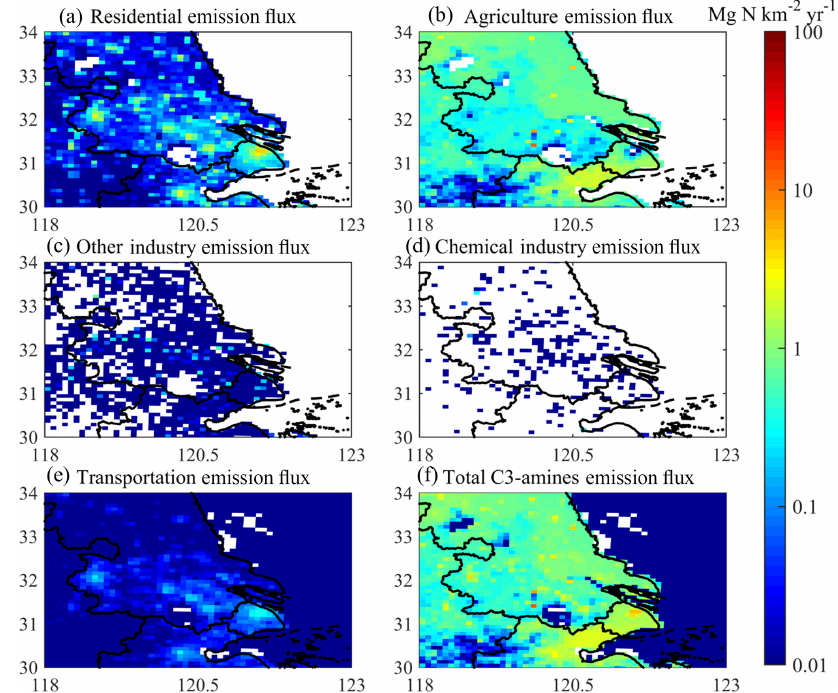
Figure 4. Same as Fig. 2 but for